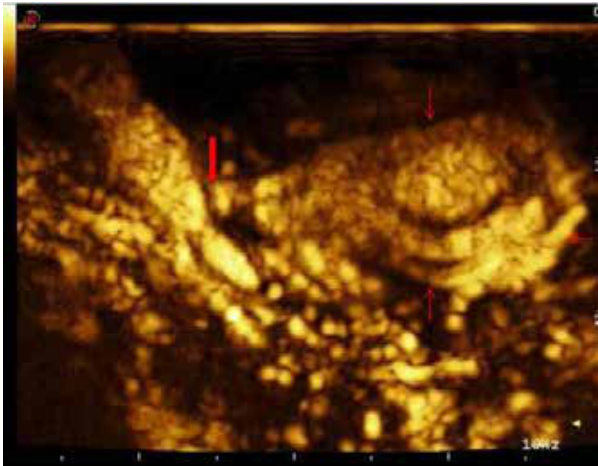
Figure 3 Contrast-enhanced ultrasonography showing the bright “rupture” (thick arrow) and “turbulent flow” within the mass (thin arrow).